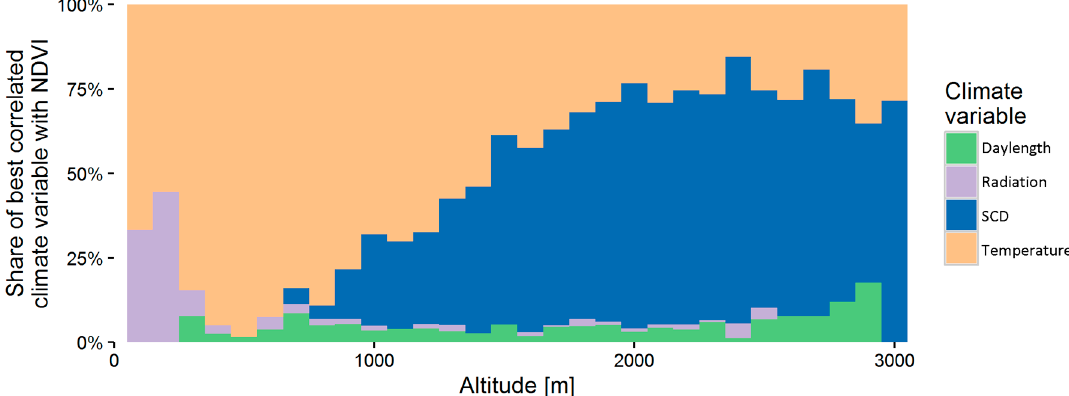
Figure 15. Common seasonality of NDVI with climate. For each 100 m altitude class are shown the percentages of climate variables that have the highest correlation with NDVI in South Tyrol (percentages of grid cells in each altitude class). The correlations have been assessed with possible time lags (see also Figure S8), and here the best correlating variable of all time lags is shown.